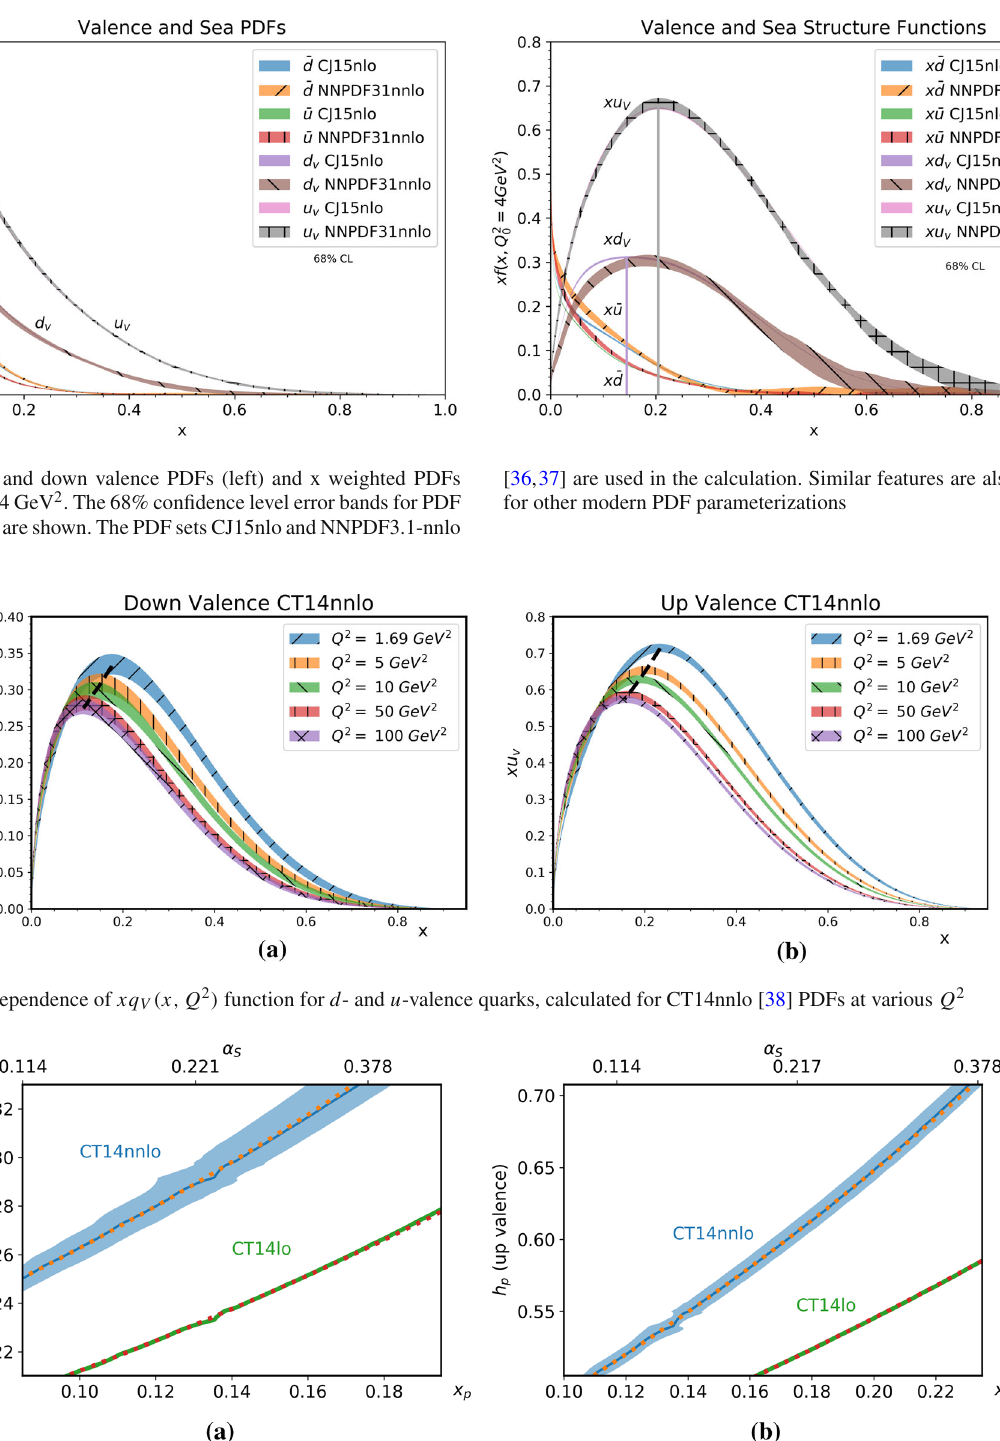
PDF parameterizations also result in an exponential form of the peak height-position correlation. The CT14nnlo is the Hessian error at 68% confidence level, while the CT14lo shows just the central